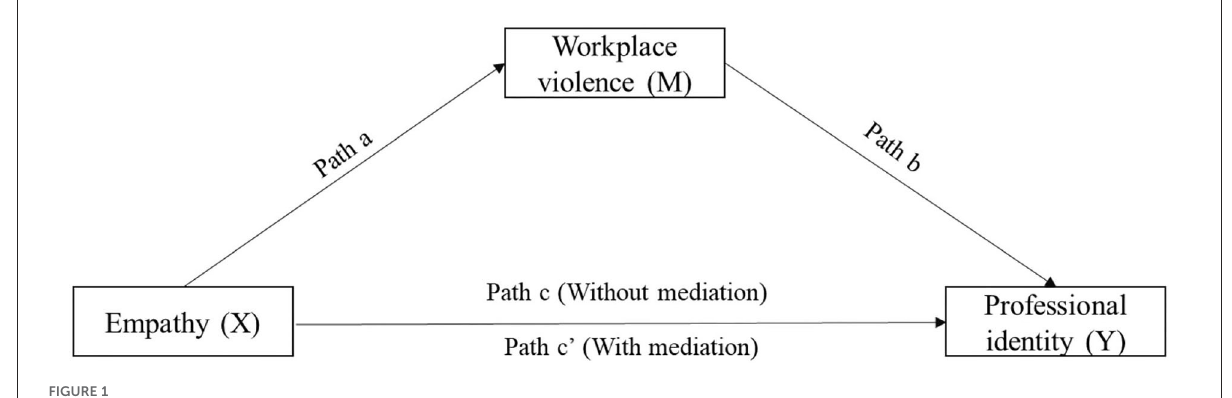
FIGURE1 Theoretical framework of this study.